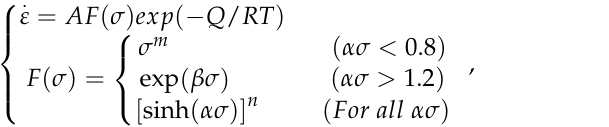
Figure 3. Relationship between: ( a ) 𝜎 (𝐴 + 𝐵𝜀 𝑛 )⁄ − 1 and ln 𝜀̇ ∗ ; ( b ) ln [ 1 − 𝜎 (𝐴 + 𝐵𝜀 𝑛 )⁄ ] and ln𝑇 ∗ .